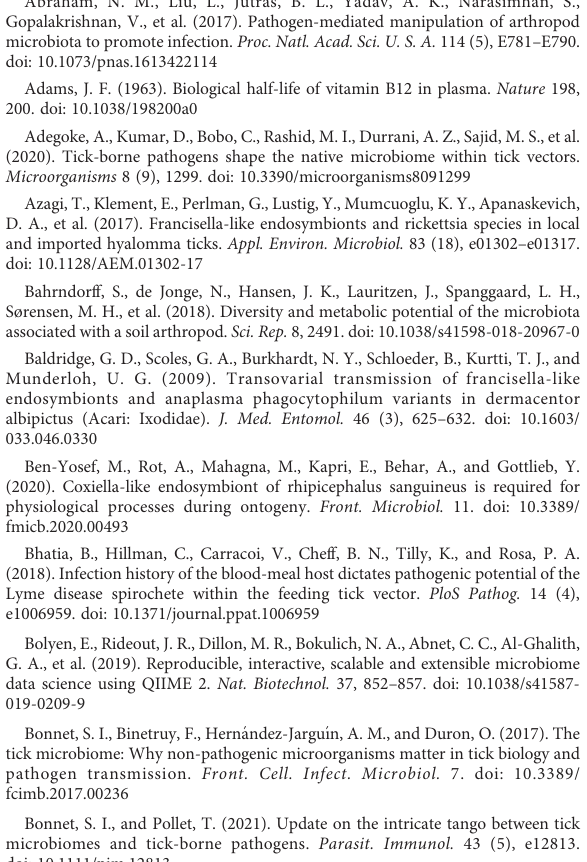
SUPPLEMENTARY FIGURE 3 Stability of bacterial abundances across developmental stages. The relative abundances of the predominant members of microbial communities in (A) all developmental stages, (B) unfed and fully fed developmental stages and (C) R. parkeri -infected and uninfected developmental stages. Each bar on the abundance plot represents average data from 3 – 5 individual replicates. Unfed (UF), fed (F), larvae (LV), nymph (N), male (M), female (F), clean (CL), infected (IN). SUPPLEMENTARY FIGURE 6 Changes in microbial assemblages and diversity across different tissues. The relative abundances of the predominant members of microbial communities in (A) all isolated tissues, (B) unfed and fully fed tissues, and (C) R. parkeri -infected and uninfected tissues. Each bar on the abundance plot represents average data from 3 – 5 individual replicates. Unfed (UF), fed (F), larvae (LV), nymph (N), male (M), female (F), clean (CL), infected (IN), salivary gland (SG), midgut (MG), ovary